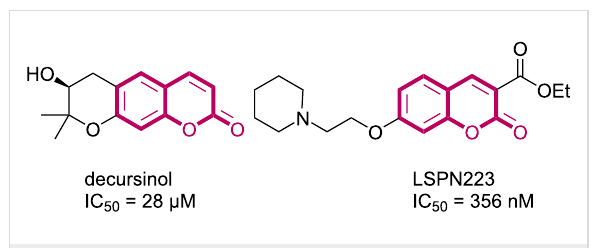
Figure 2: Inhibition of acetylcholinesterase by coumarin derivatives.